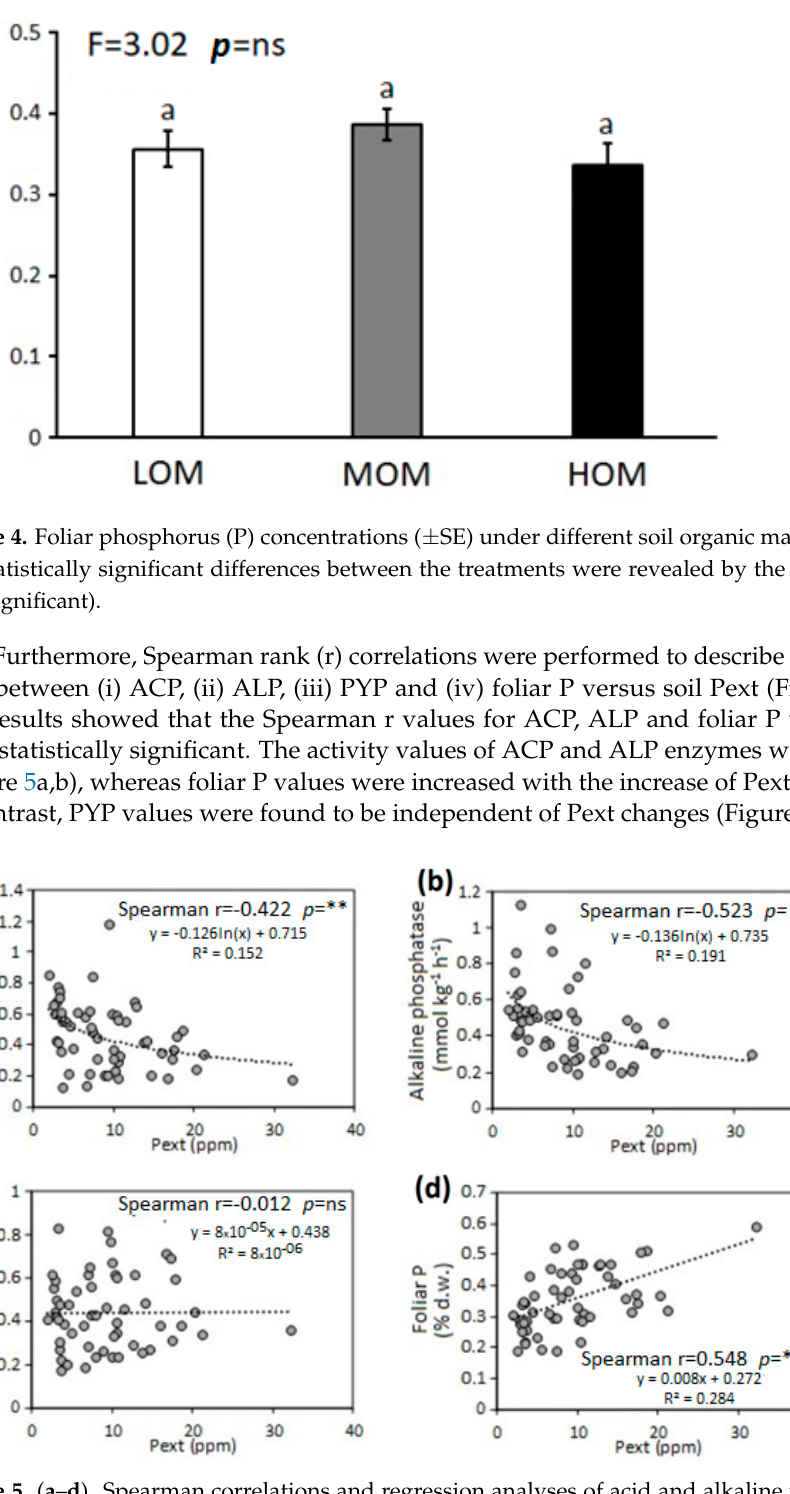
Figure 5. ( a – d ). Spearman correlations and regression analyses of acid and alkaline phosphatase, pyrophosphatase activity and foliar P concentration in relation to soil available P (Pext) (Spearman correlation coefficient: ns = non-significant; **: p ≤ 0.01; ***: p ≤ 0.001).